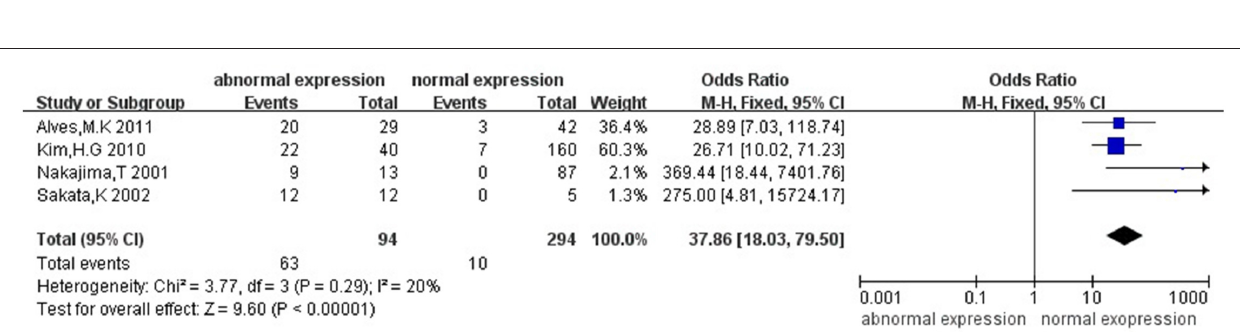
FIGURE 7 | Forest plot concerning hMLH1 methylation and hMLH1 protein expression. Fixed-effect model was used.